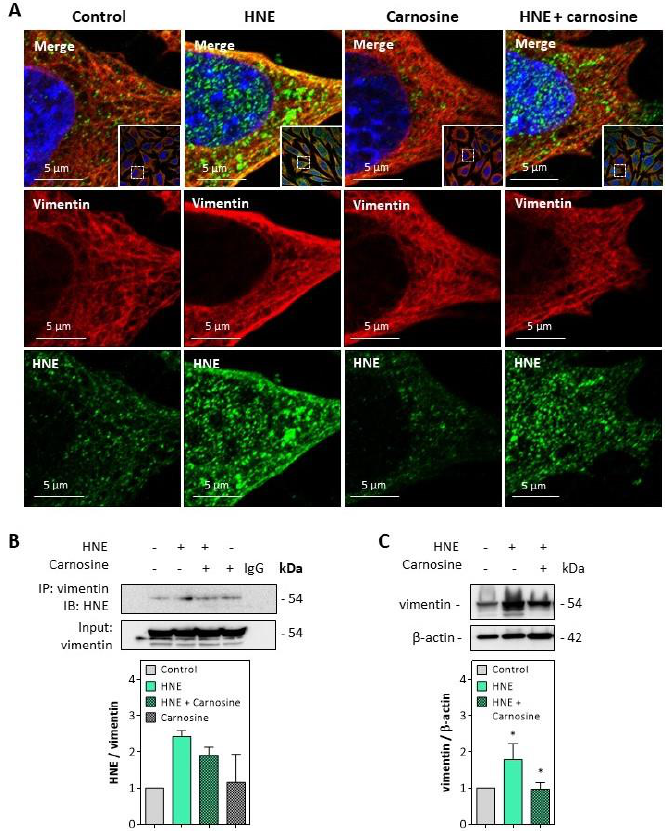
Figure 5. HNE adduct formation on vimentin in fibroblasts exposed to HNE. Cultured fibroblasts were exposed to UV-A (two cycles of irradiation, each up to 15 J/cm 2 in HBSS medium) or HNE (30 µM, 4 h in HBSS medium), ± carnosine (100 µM). Western blot analyses were carried out on cells incubated with HNE as described above, followed by 24 h incubation at 37 °C in fresh RPMI medium supplemented with 1% FBS as indicated in the Method section. ( A ), Representative confocal imaging pictures showing the presence of HNE adducts (green, lower panel) on vimentin (red, middle panel), and the merge (yellow, upper panel), in fibroblasts incubated with HNE, and protective effect of carnosine. Nuclei were stained with DAPI (blue). Scale bar, 5 µm. In insert, original 63× confocal image. ( B ), Detection of HNE adducts on vimentin immunoprecipitates from fibroblasts incubated with HNE and protective effect of carnosine (mean of two separate experiments) ( C ), Expression of vimentin in fibroblasts incubated with HNE and protective effect of carnosine. These results are the mean of three separate experiments and are expressed as means ± SEM. Statistical analysis was assessed using a Student t-test. * p < 0.05.